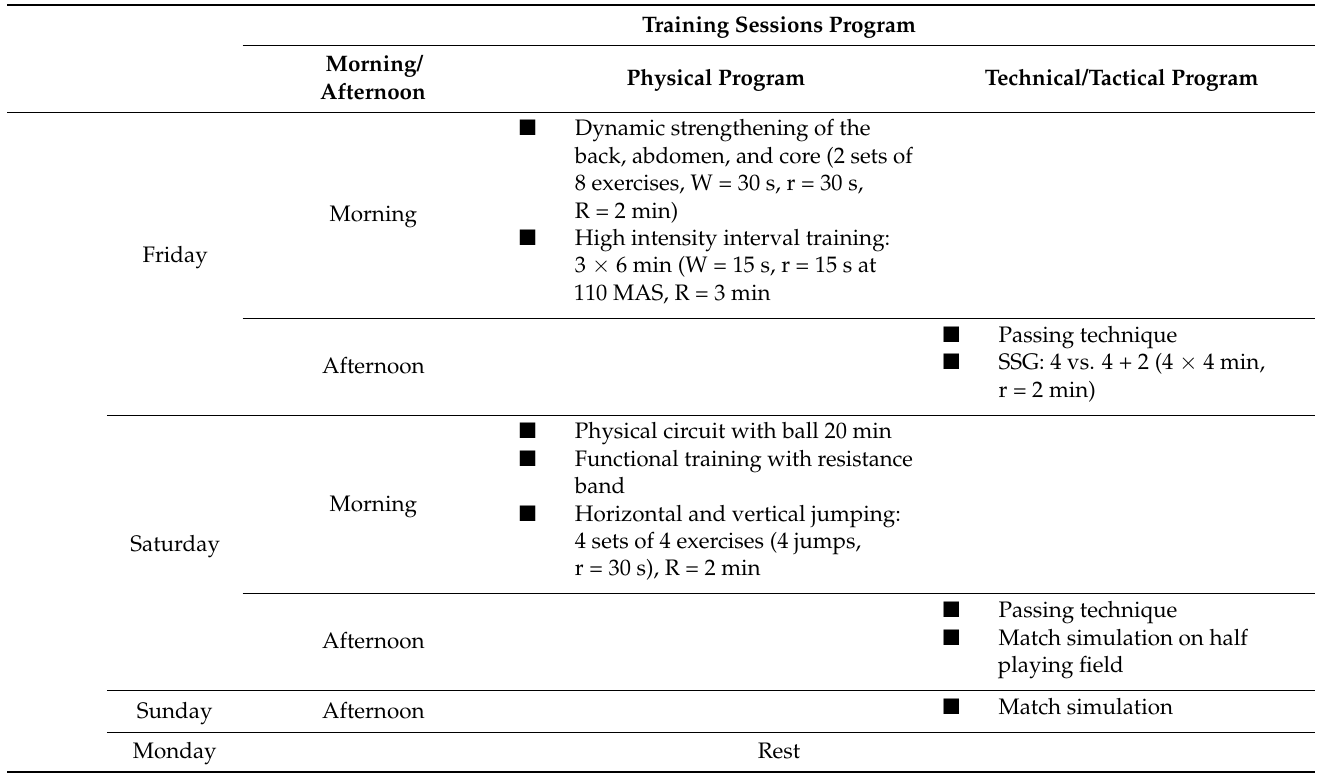
Technical/Tactical